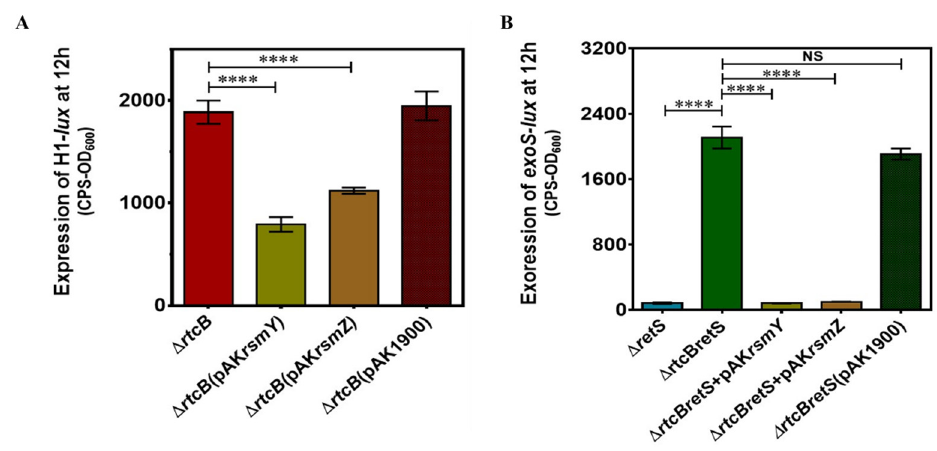
Figure 7. Complementation of rtcB deletion mutants with RsmY/Z overexpressing vectors altered H1-T6SS and exoS reporter activity. Expression of H1-T6SS ( A ) and exoS ( B ) was measured in mutant strains. Data were analyzed using one-way ANOVA with Dunnette post-hoc test, NS p > 0.05, **** p < 0.0001.